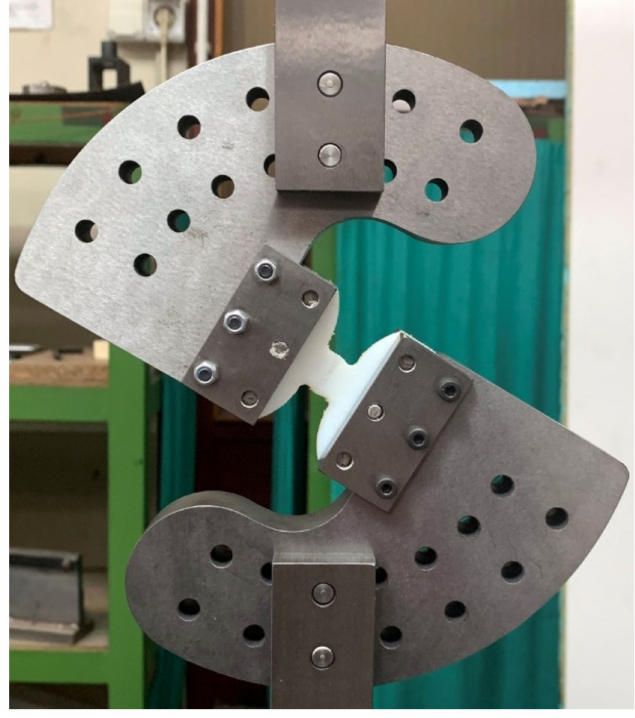
Figure 2. Arcan device at 30 ◦ .